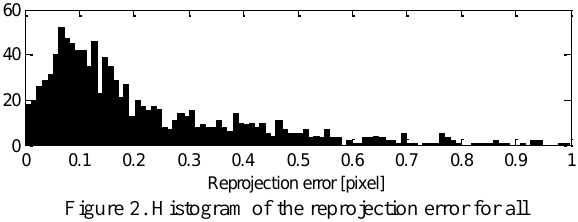
Figure 2. Histogram of the reprojection error for all measurements of all